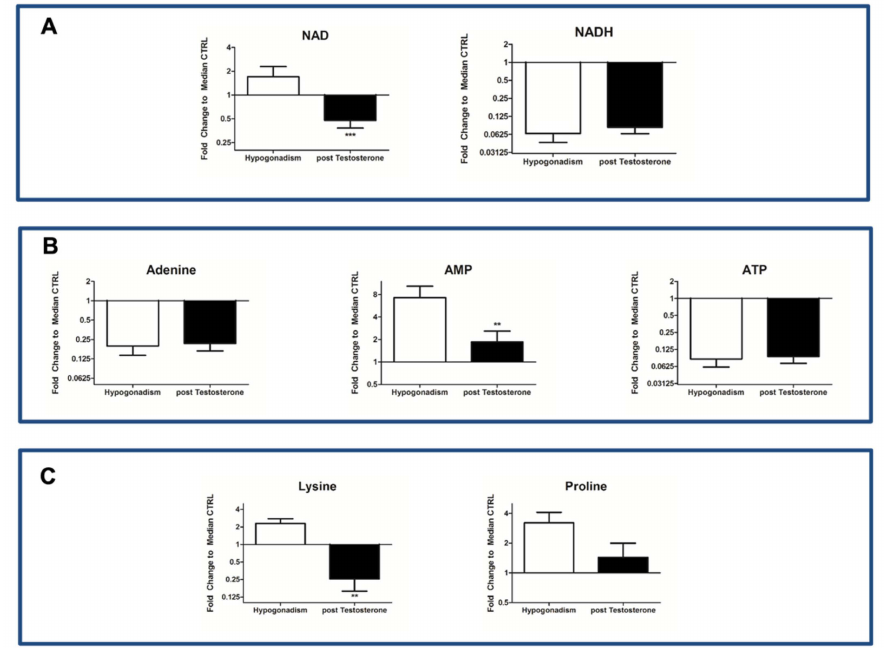
Figure 5. NAD and NADH changes after TRT in hypogonadism Panel ( A ). Down-regulation of TCA cannot restore NAD reduction. Adenine, AMP, and ATP levels were not restored after therapy Panel ( B ). Proline and lysine, amino acids involved in collagen biosynthesis, pre and after TRT Panel ( C ). All data are shown as mean ± SEM of fold-change relative to the metabolite levels in controls. ** p < 0.01, *** p <